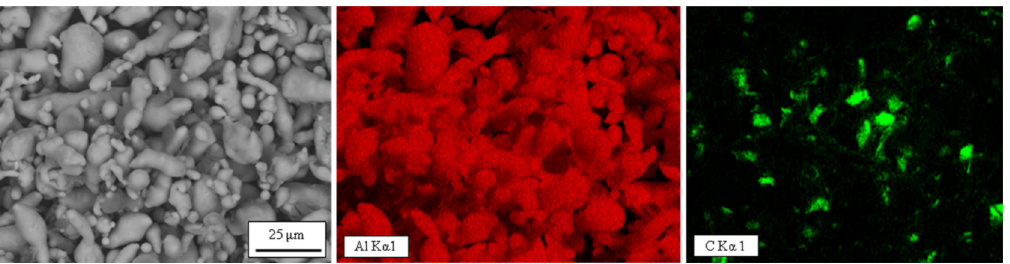
Figure 4. Energy ‐ dispersive X ‐ ray spectroscopy (EDS) maps of Al ‐ 1 wt. % GNP composite after mixing by the wet mixing technique, reproduced from [70], with permission from Springer Nature, 2018.